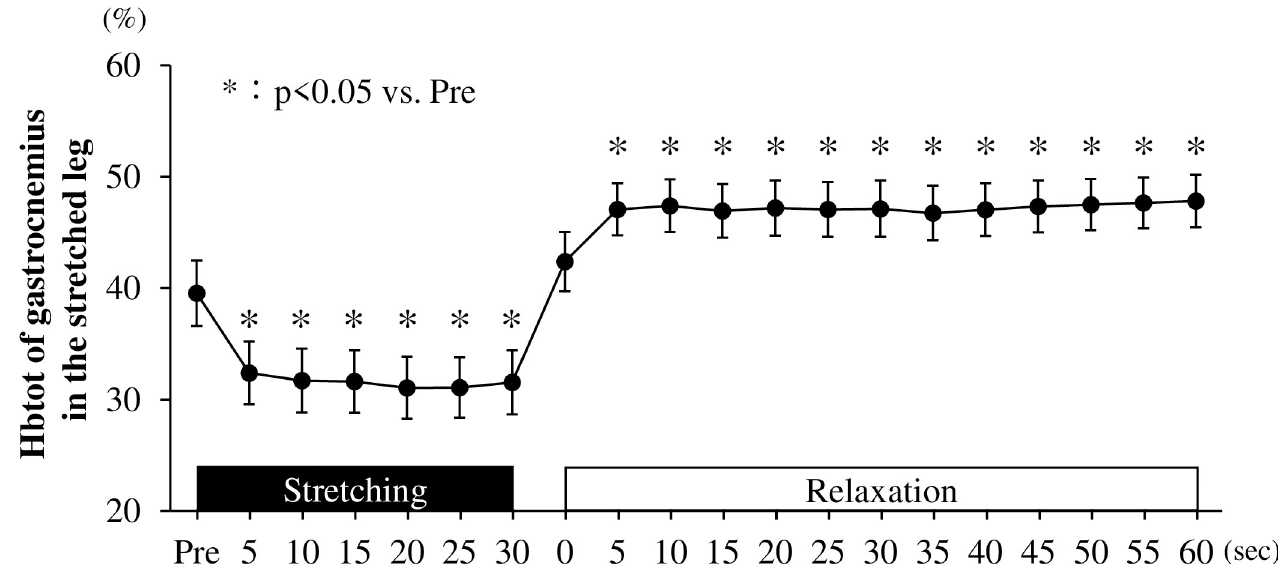
Fig 4. Total hemoglobin (Hbtot) of the gastrocnemius muscle in the stretched leg before, during, and after passive one-legged calf stretching. Pre, before stretching; � P < 0.05 vs. Pre. Data are presented as mean ± SE.